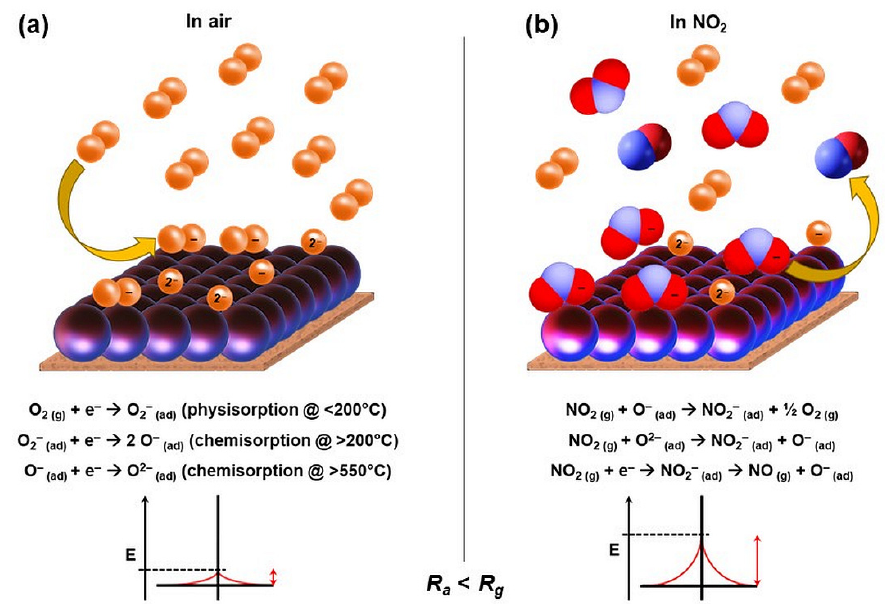
Figure 9. The gas sensing mechanism of ZnFe 2 O 4 nanoparticles-based chemiresistive gas sensors.